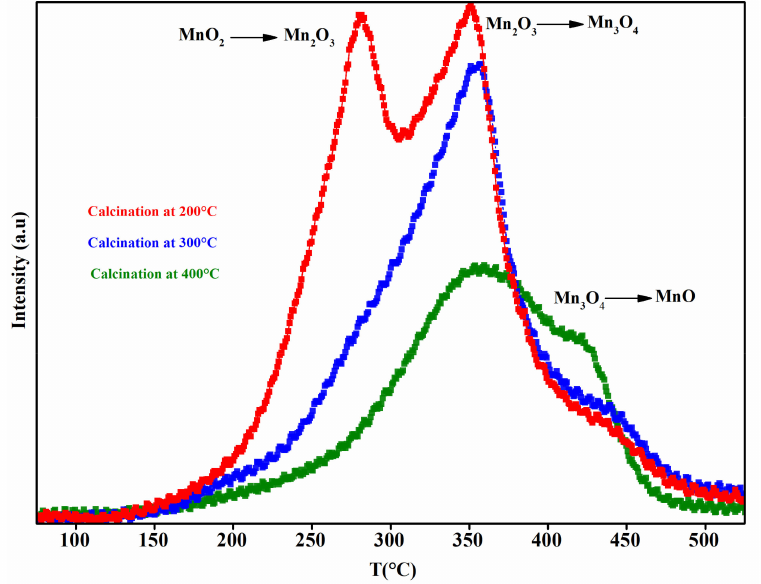
Figure 3. H 2 -TPR profiles of the 5Mn/TiO 2 mM samples calcined at various temperatures (200, 300 and 400 ◦